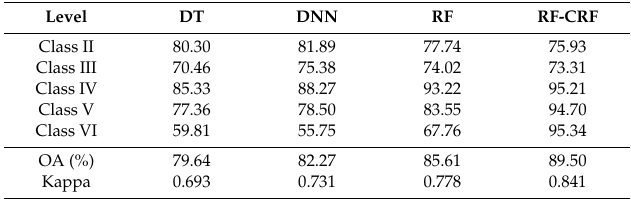
Table 6. Comparison of the di ff erent classification accuracy results (%) for the Wuhan dataset.